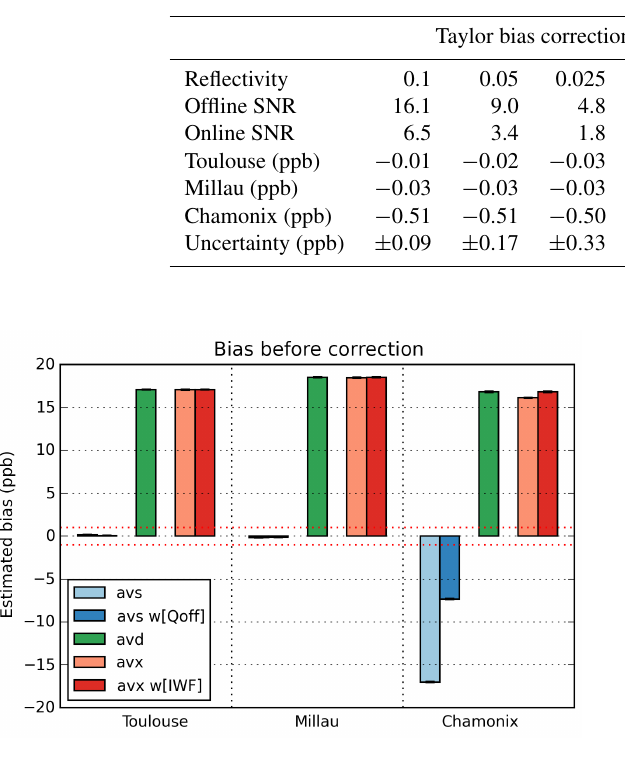
Figure 10. Bias before correction for the three studied averaging schemes (red dotted lines: targeted bias ±